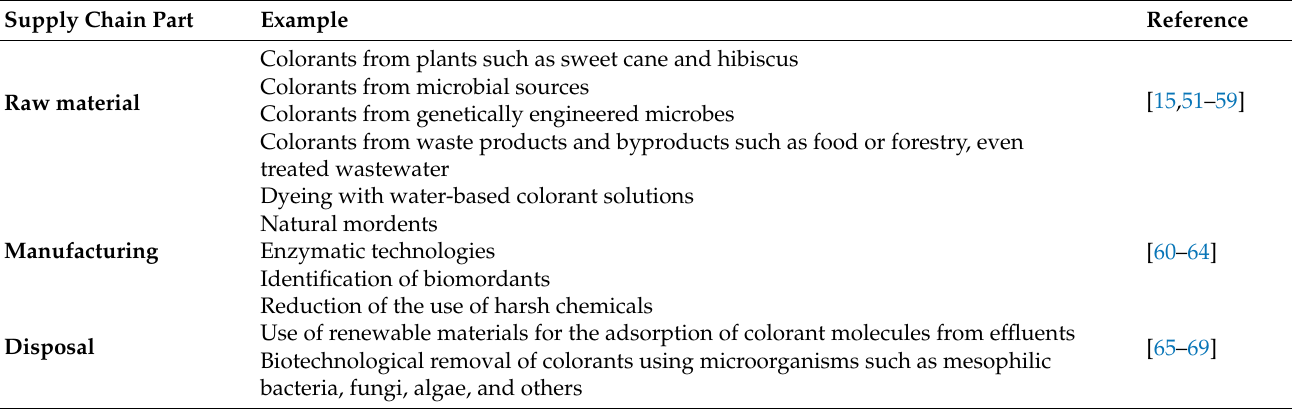
Table 1. Examples of how biotechnology has tackled the sustainability of the extended supply chain of the textile